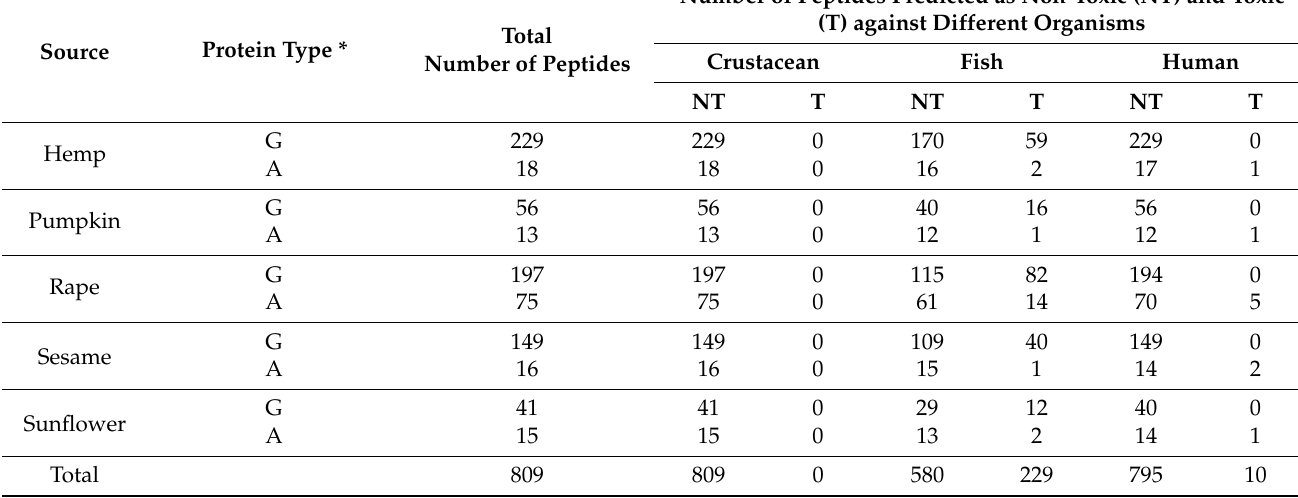
Table 2. In silico prediction of crustacean, fish and human toxicity of oilseed-derived peptides.